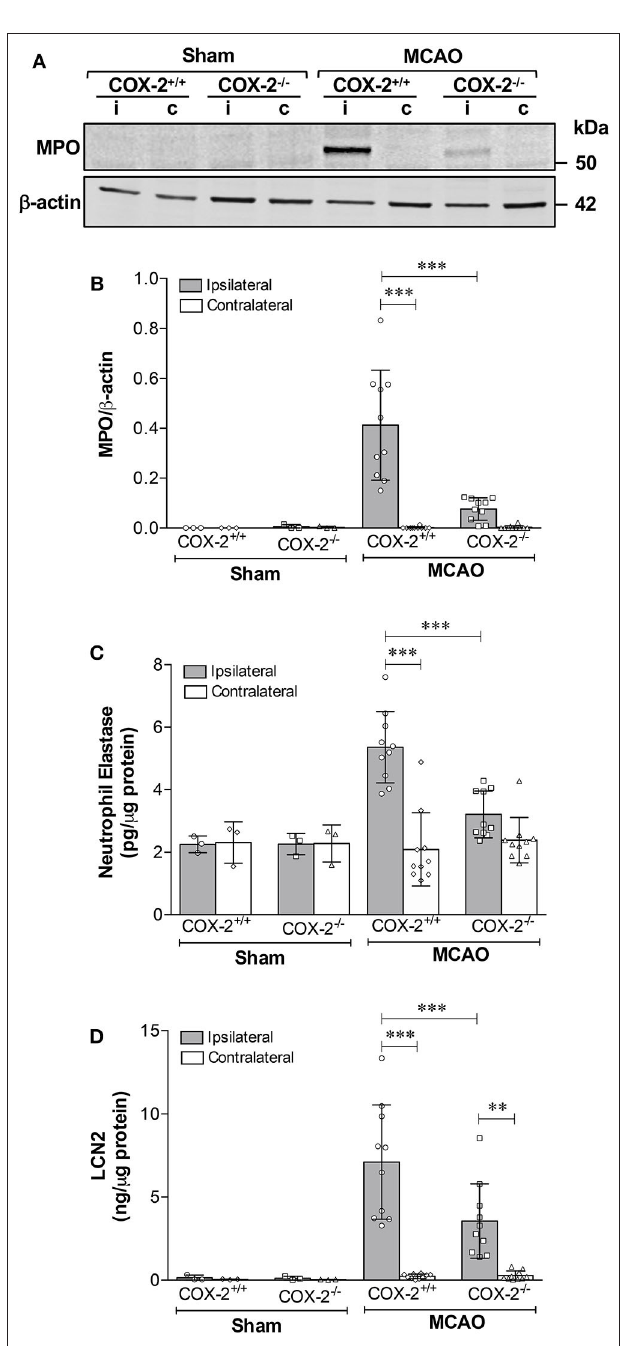
FIGURE 4 | COX-2 deficiency results in less neutrophil infiltration and reduced protein levels of neutrophil elastase and lipocalin-2. Transient MCAO followed by 24h of recirculation produced a significant infiltration of neutrophils as measured by myeloperoxidase (MPO) protein levels in the ischemic cerebral cortex. Genetic deletion of COX-2 prevented stroke-induced increase in MPO, which is suggestive of less neutrophil infiltration into the injured brain. (A) Representative western blot for MPO in homogenates from ipsilateral (i) and contralateral (c) cerebral cortices. (B) Densitometric analysis of MPO normalized to β -actin. (C) Neutrophil elastase protein levels measured by ELISA in cortical homogenates from COX-2 + / + and COX-2 − / −